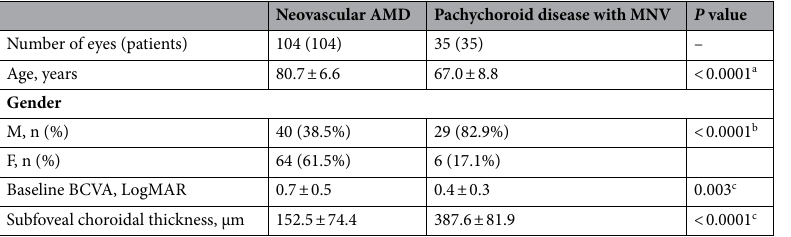
Table 1. Characteristics of enrolled patients. Quantitative values are expressed in mean ± SD (standard deviation). BCVA best corrected visual acuity (logMAR [logarithm of the minimum angle of resolution]).